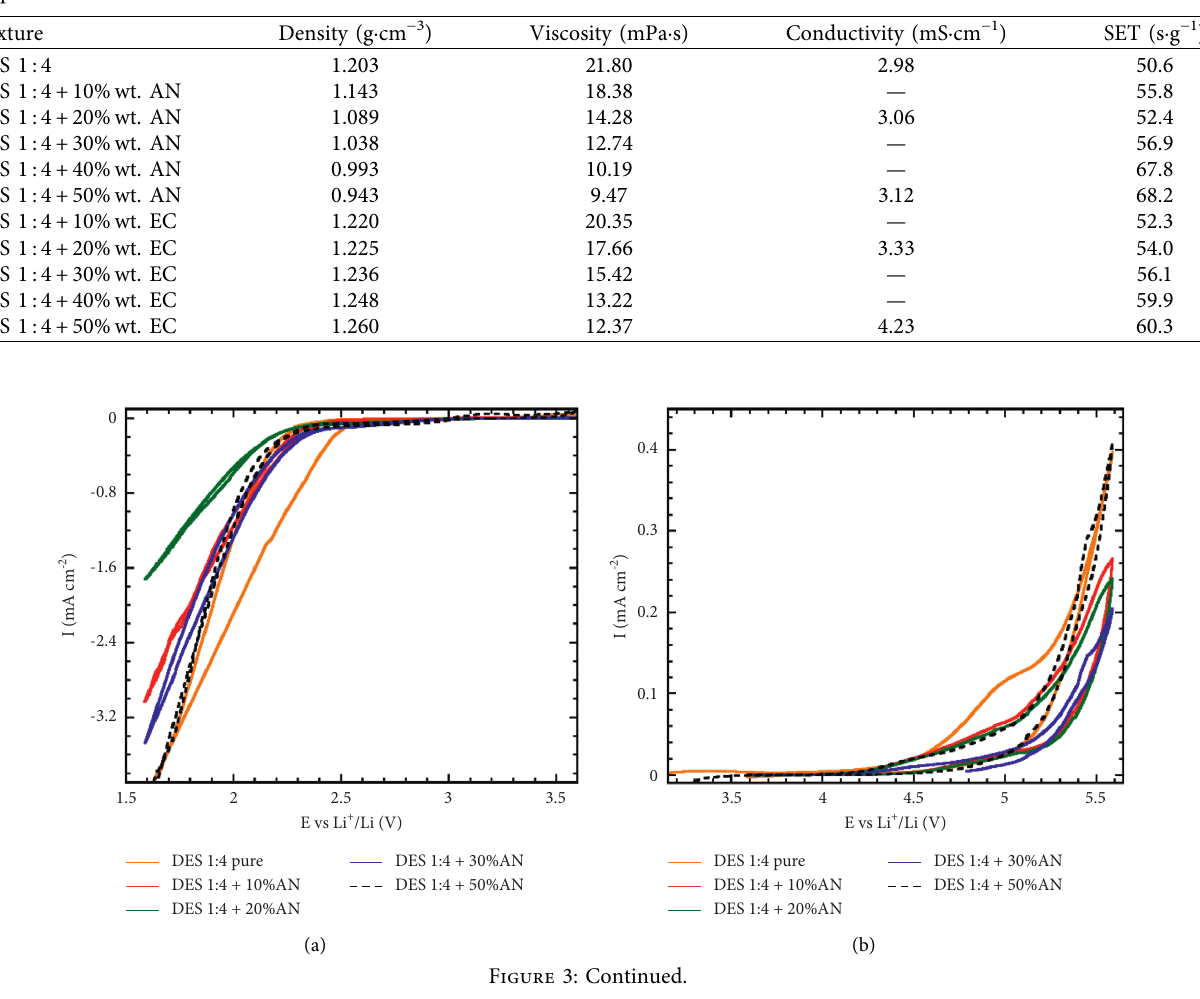
Figure 2: Thermogravimetric curves of DES-AN (a) and DES-EC-based electrolytes (b). Table 2: Density, viscosity, ionic conductivity, and self-extinguishing time (SET) of DESs and mixtures of DES+ x % wt. AN (or EC) at room temperature.